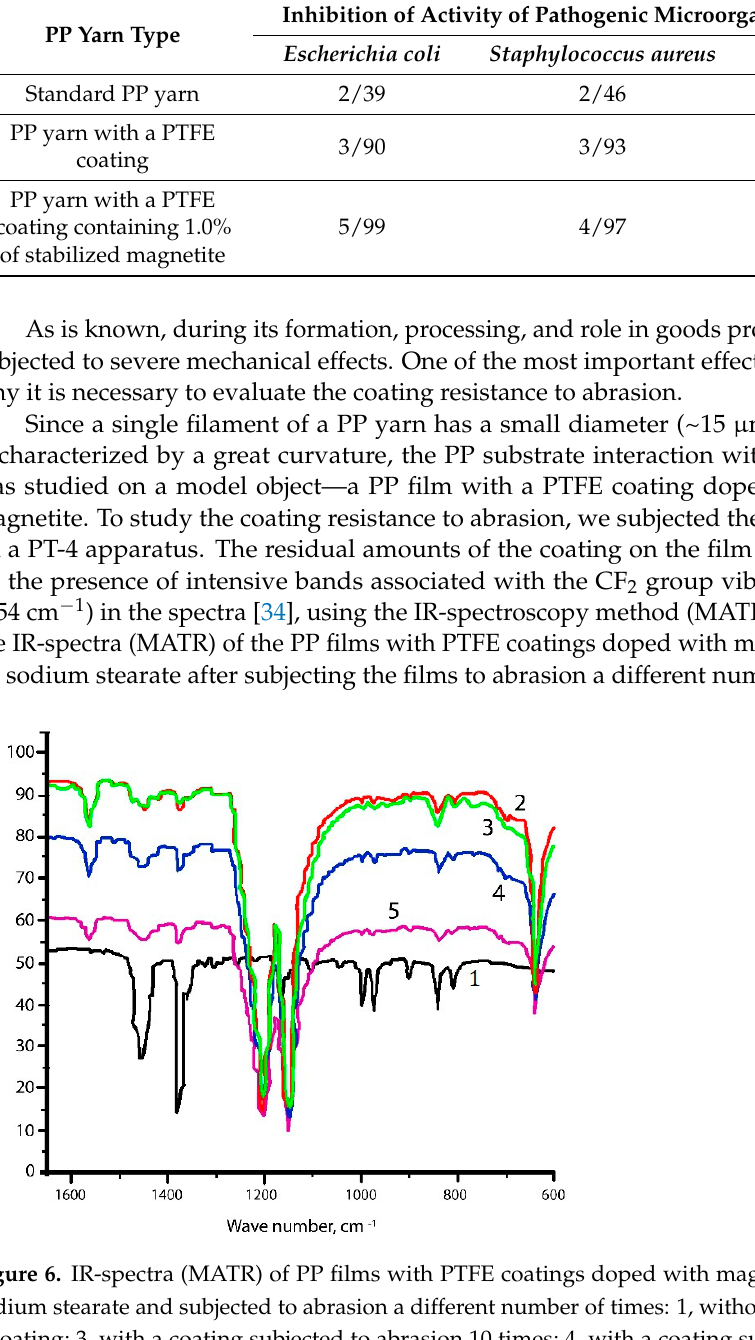
Table 3. Antimicrobial properties of a PP yarn with a PTFE coating containing stabilized mag- netite particles.